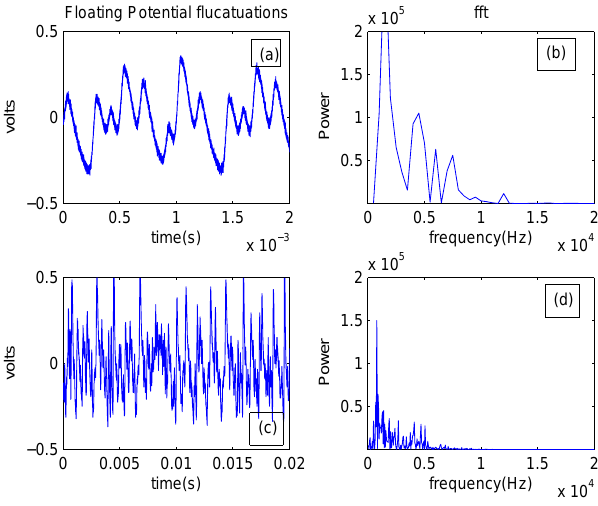
Fig. 2. Top plots are the quasi periodic data (a) and its fft (b) , while the bottom plots are the chaotic data (c) and its fft (d)